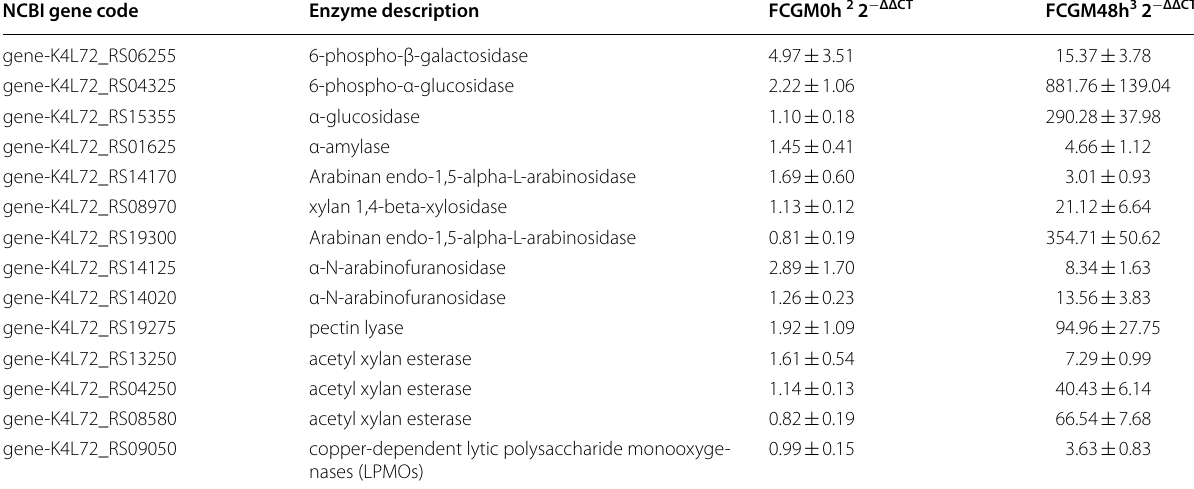
1 Values are means of three replicates per treatment 2 FCGM-0 h: CGM was inoculated with B. velezensis CL-4 at 37 °C for 0 h 3 FCGM-48 h: CGM was inoculated with B. velezensis CL-4 at 37 °C for 48 h